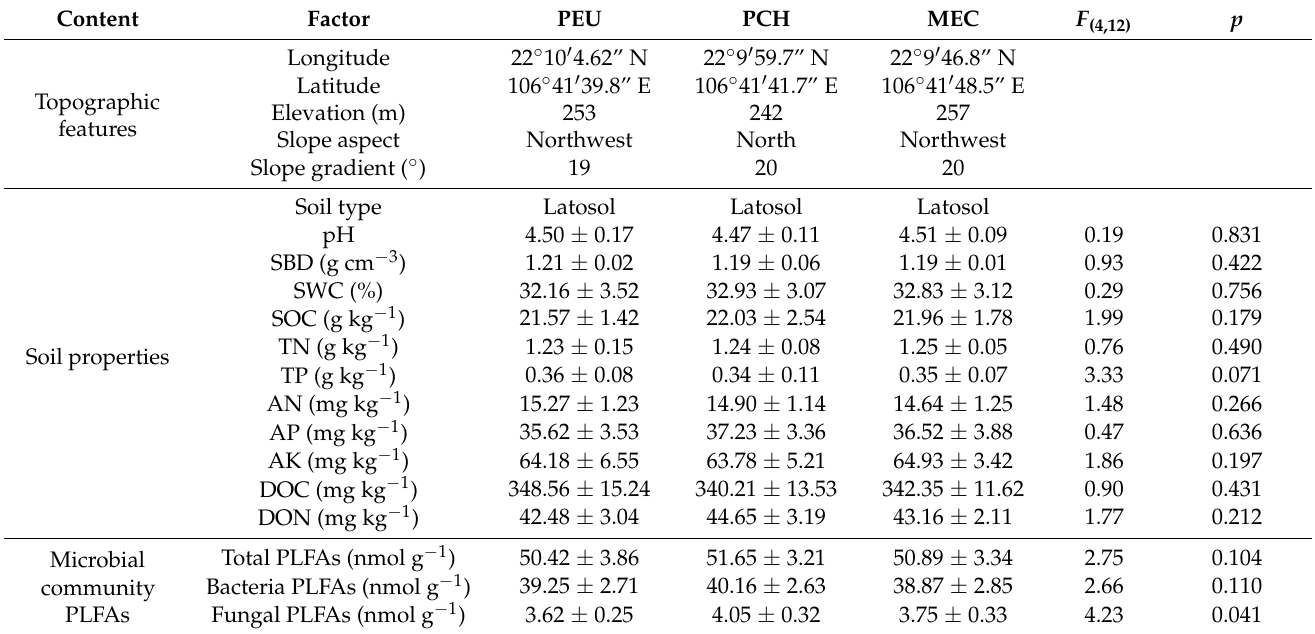
Table 2. Background data of topographic features, soil properties, and microbial community phospho- lipid fatty acids (PLFAs), in the 0–10 cm depth layer in different plantations. Mean ± standard error ( n = 5). F -values are results of one-way ANOVA. See Table 1 for the abbreviations of soil